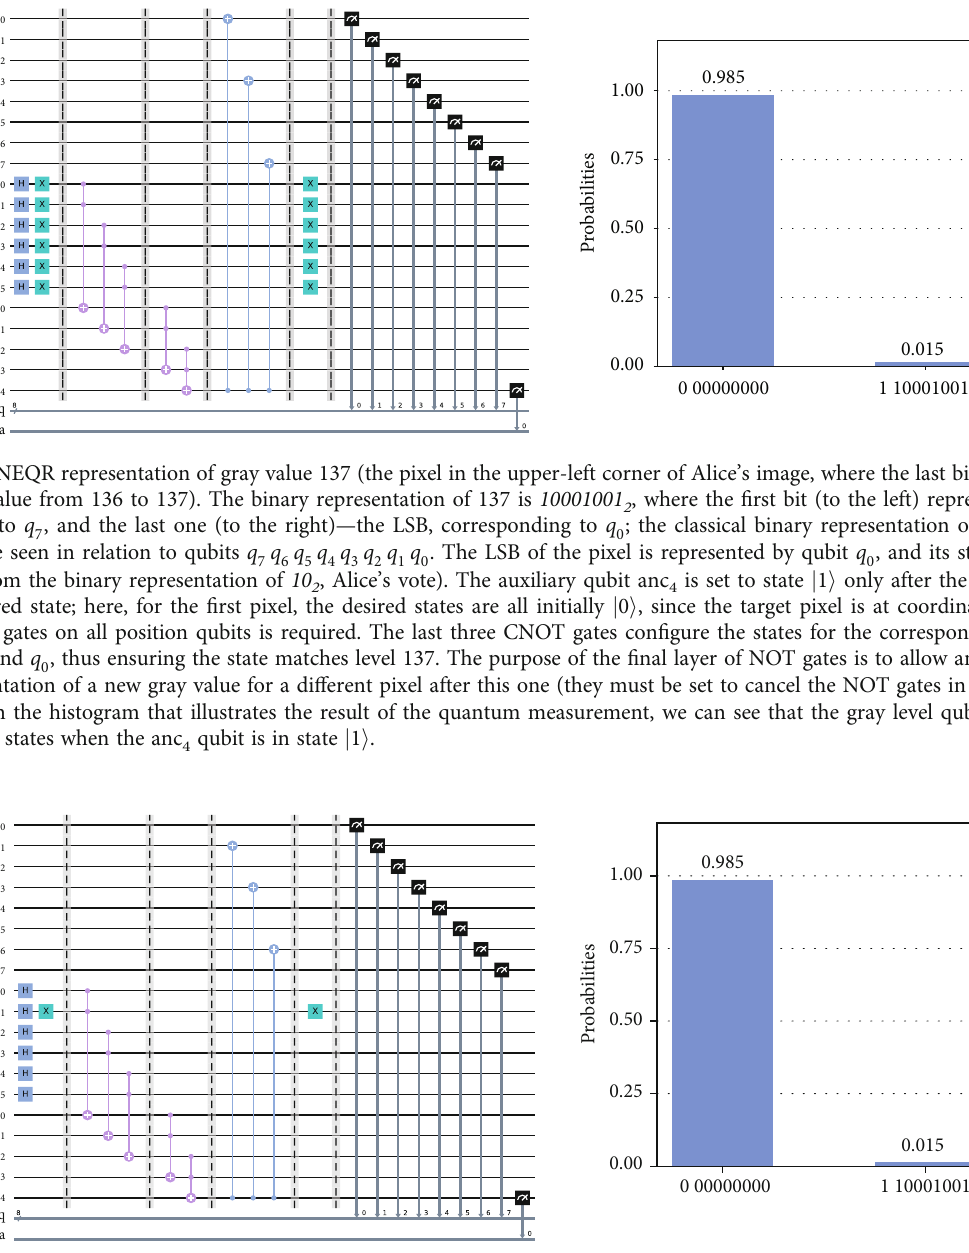
Figure 6: The NEQR representation of gray value 74 (the pixel in the lower-right corner of Alice ’ s image). The LSB is represented by qubit q j 0 i (the second bit from the binary representation of 10 , Alice ’ s vote in binary). The voter needs to add a NOT gate 0 , and its state is set to 2 in the validation circuit for this qubit ( q 0 ). In a similar manner to the representation in Figure 5, the q 7 q 6 q 5 q 4 q 3 q 2 q 1 q 0 representation must match the binary value of 74, which is 00101111 , when the position qubits are in the expected states. Here, the pixel ’ s coordinates 2 are (5, 7) — values 101 ( qp 2 qp 1 qp 0 ) and 111 ( qp 5 qp 4 qp 3 ) in binary; therefore, only one NOT gate is needed for the position qubits 2 2 before the connection between anc and the gray level qubits, more exactly for qp 1 4